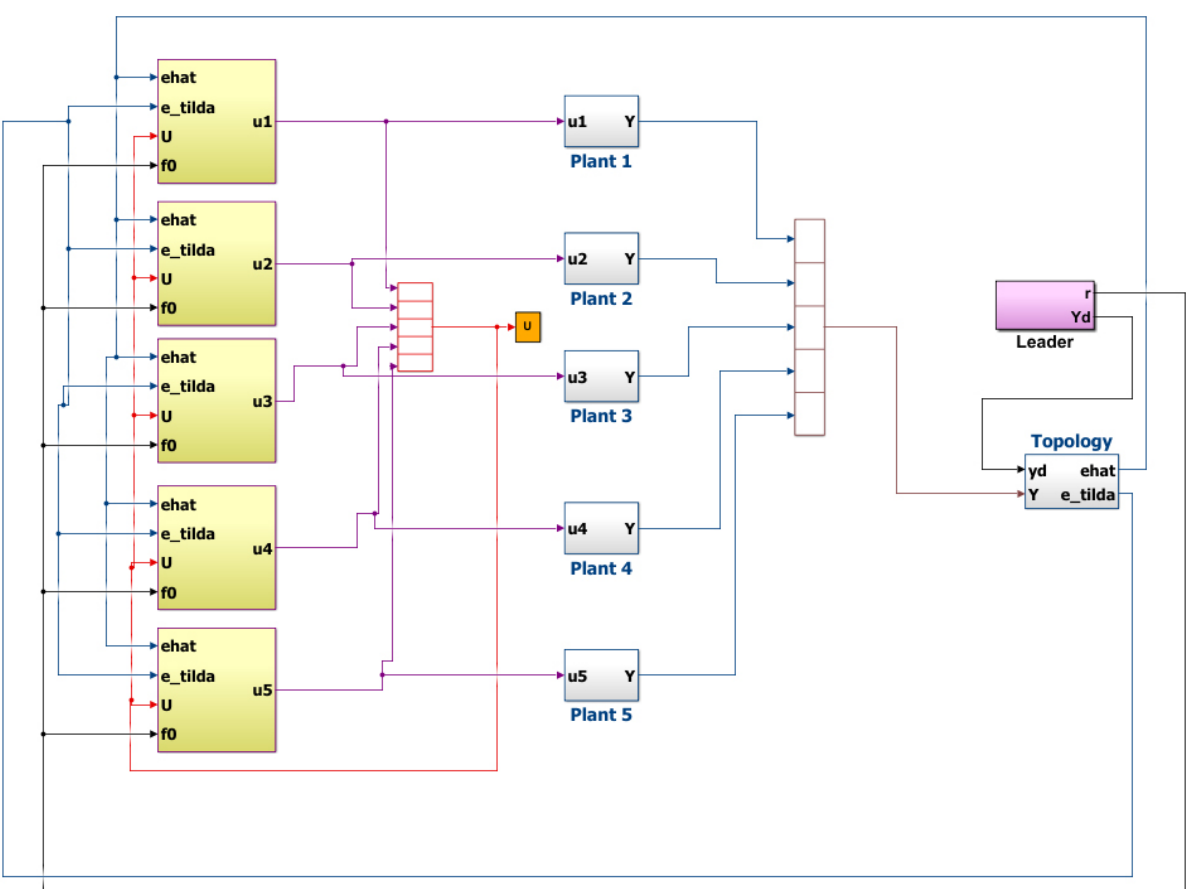
Figure 16. Matlab implementation